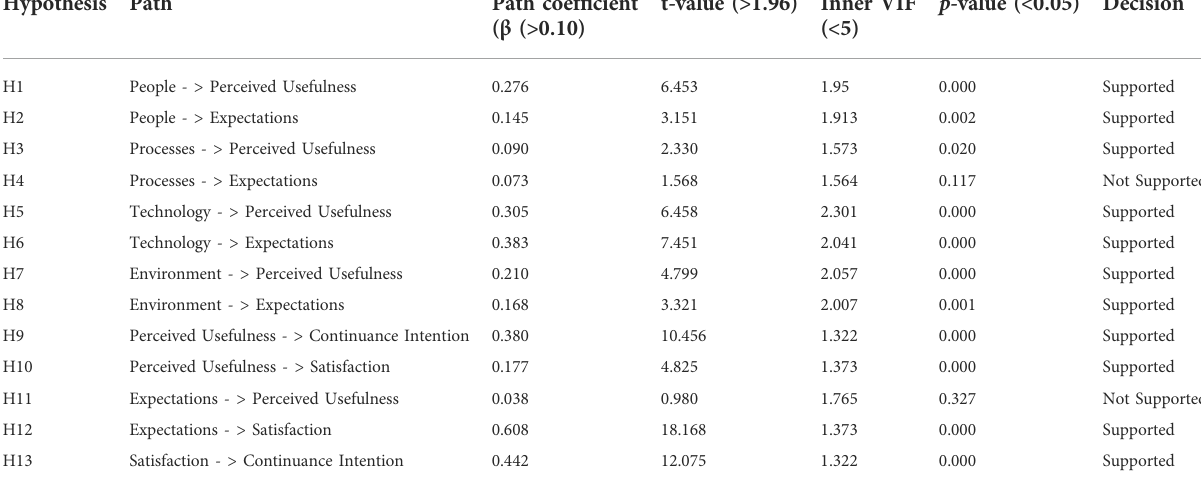
TABLE 5 Results of the structural